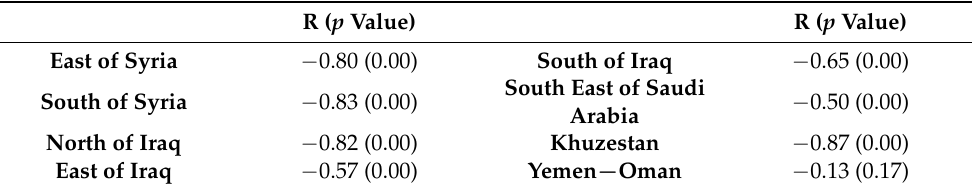
Figure 5 . Time series interannual variation in annual mean MODIS Terra AOD and NDVI. Figure 5. Time series interannual variation in annual mean MODIS Terra AOD and NDVI. Table 2. Correlation results between AOD and NDVI based on eight hot spots between 2000 and Table 1. Mean AOD for three periods (2000–2006, 2007–2013, 2014–2019) in different dust hotspot regions labeled in Figure 4 and the relative change between the 1st and subsequent periods.